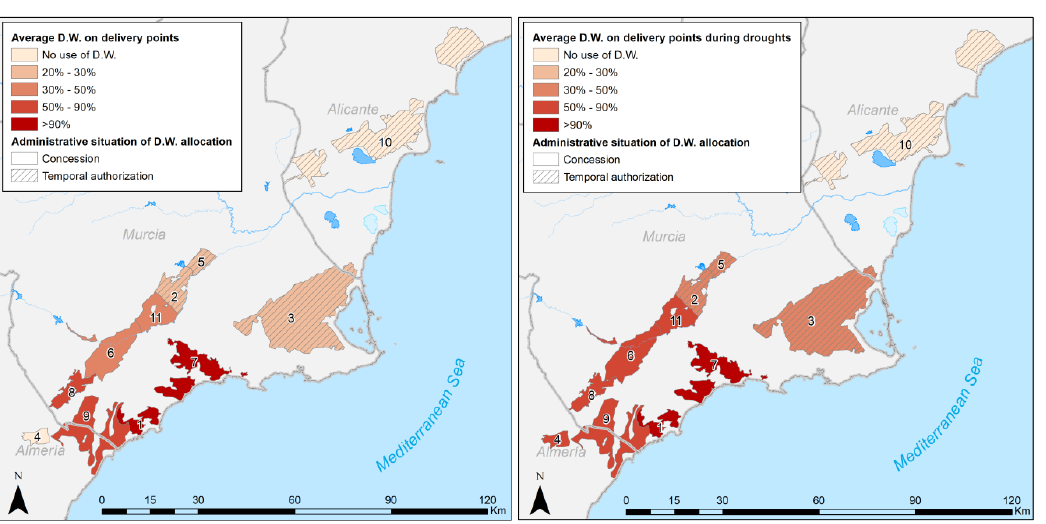
Figure 3. Average desalinated water (D.W.) use on delivery points in normal hydrologic conditions and drought situations. Note: irrigation communities: 1. Á guilas; 2. Alhama de Murcia; 3. Campo de Cartagena; 4. El Saltador; 5. Librilla; 6. Lorca; 7. Mazarrón; 8. Puerto Lumbreras; 9. Pulpí; 10. Riegos de Levante; 11. Totana.